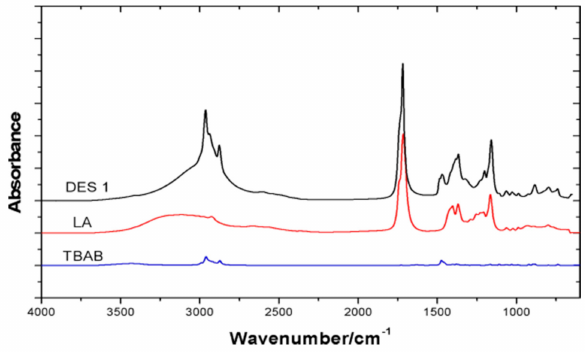
Figure 4. FT-IR spectra of TBAB, LA and DES1.